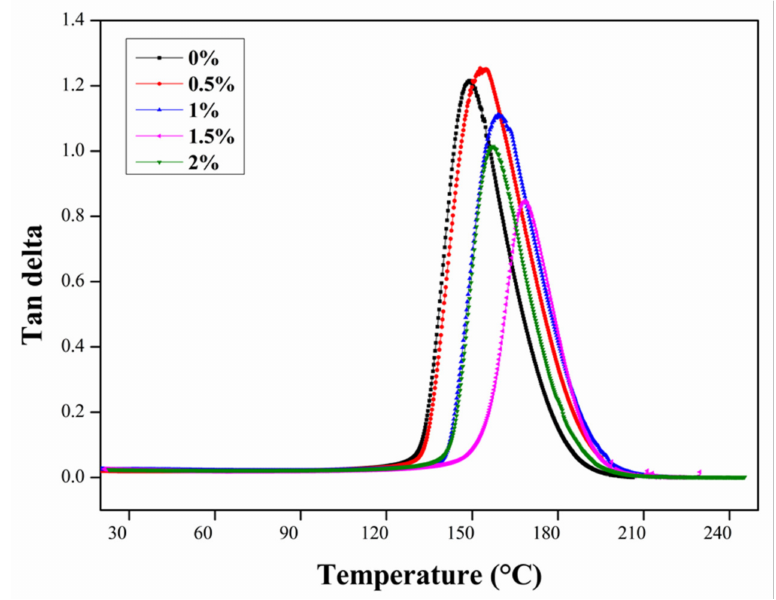
Figure 8. Tan delta vs. temperature of the epoxy/CNT